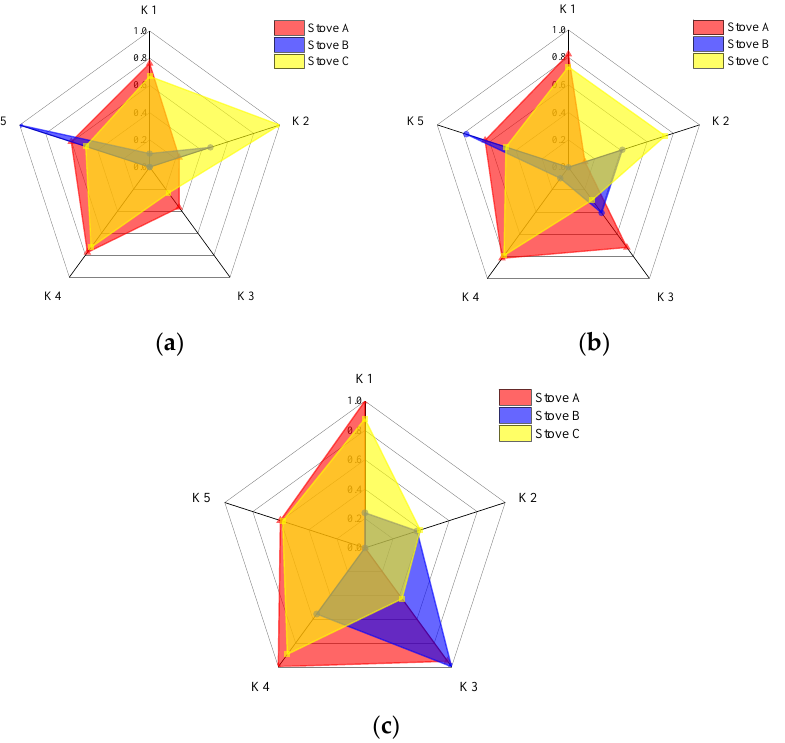
Figure 15. Performance pentagon of three stoves at different power rates: ( a ) 40 kW; ( b ) 30 kW; ( c ) 20 kW.